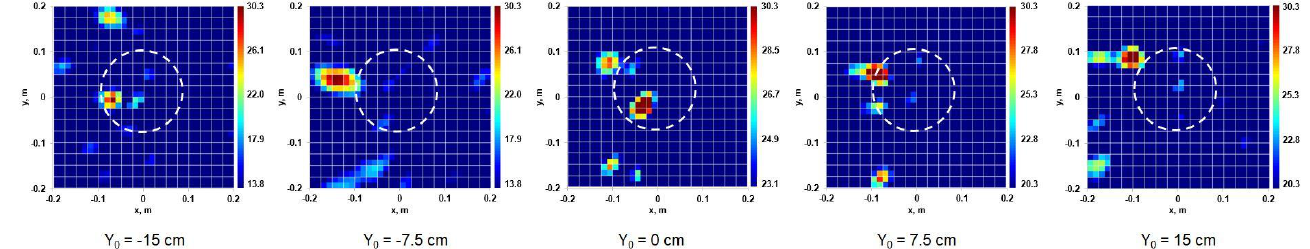
Figure 21. Images of a round-shaped object, marked with the dotted circle, under multi-position illumination from the left side.